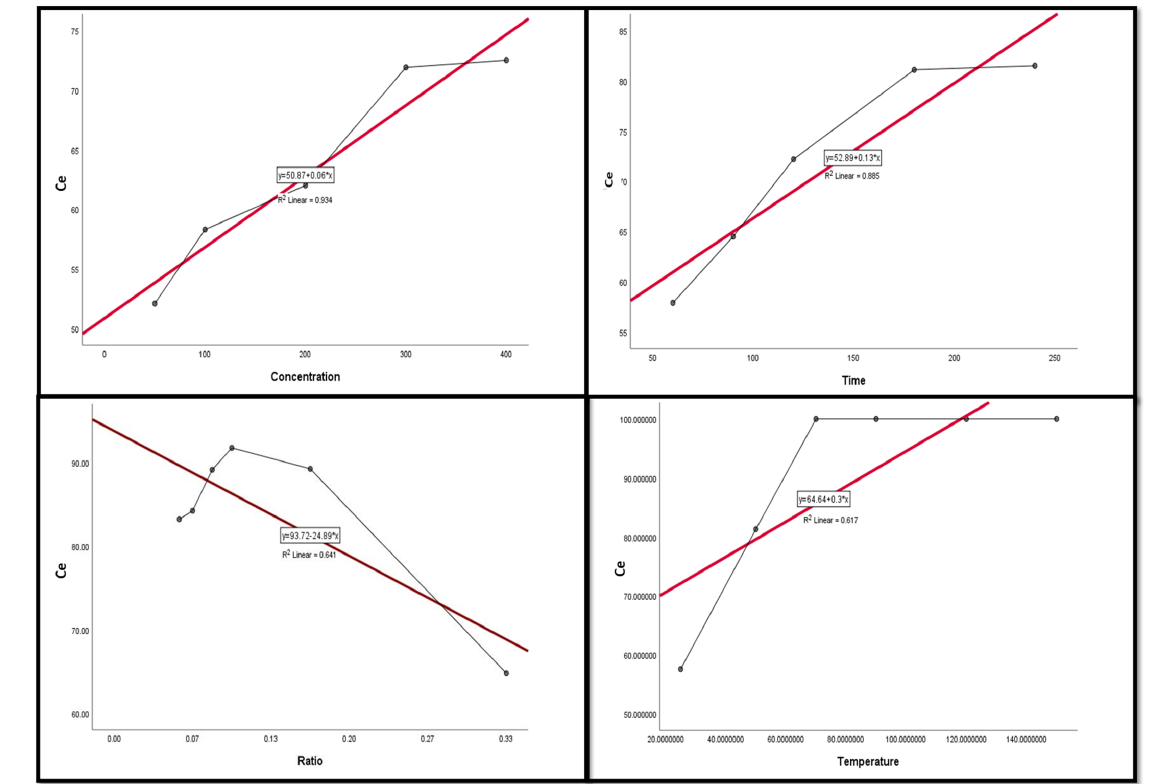
Figure 9. The scatter plot with linear regression fit for Ce leaching efficiency, %, and factors.